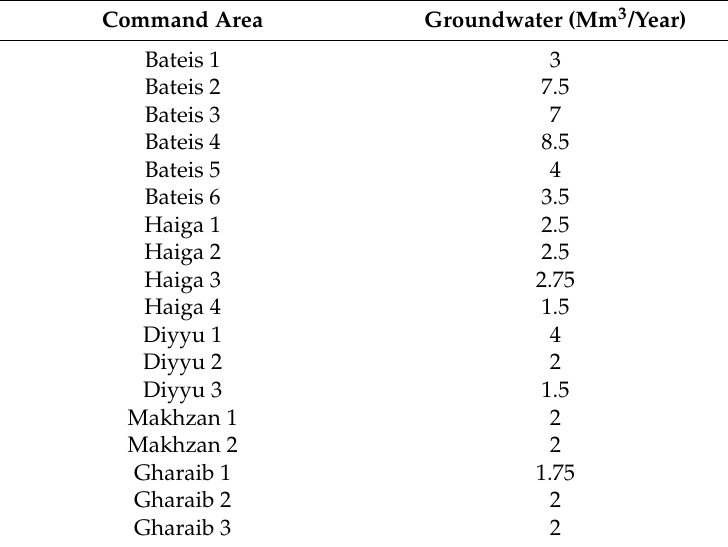
Table A1. Annual groundwater allotments per command